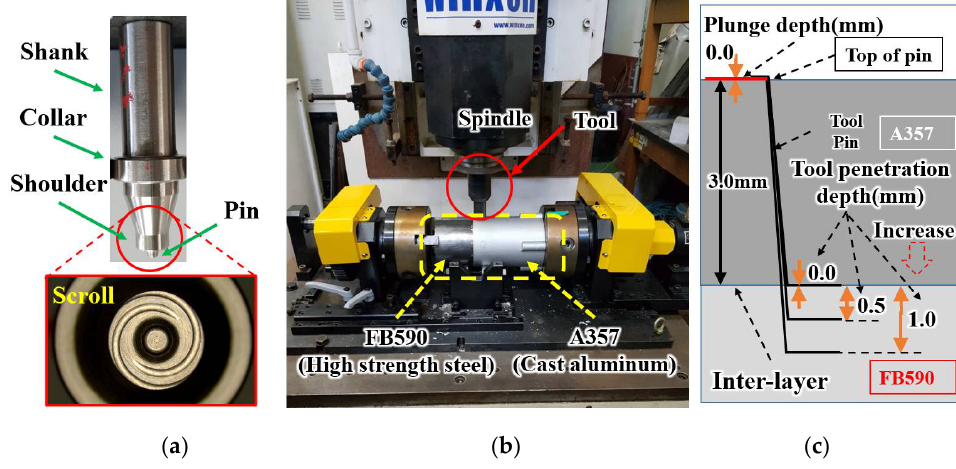
Figure 1. Overall configuration diagram of FSW experiment. ( a ) tool and close view of shoulder; ( b ) photograph of experimental equipment; and ( c ) tool penetration depth (TPD) [16]. The shoulder, pin root, and pin diameter of the tool are 10, 5, and 4 mm,